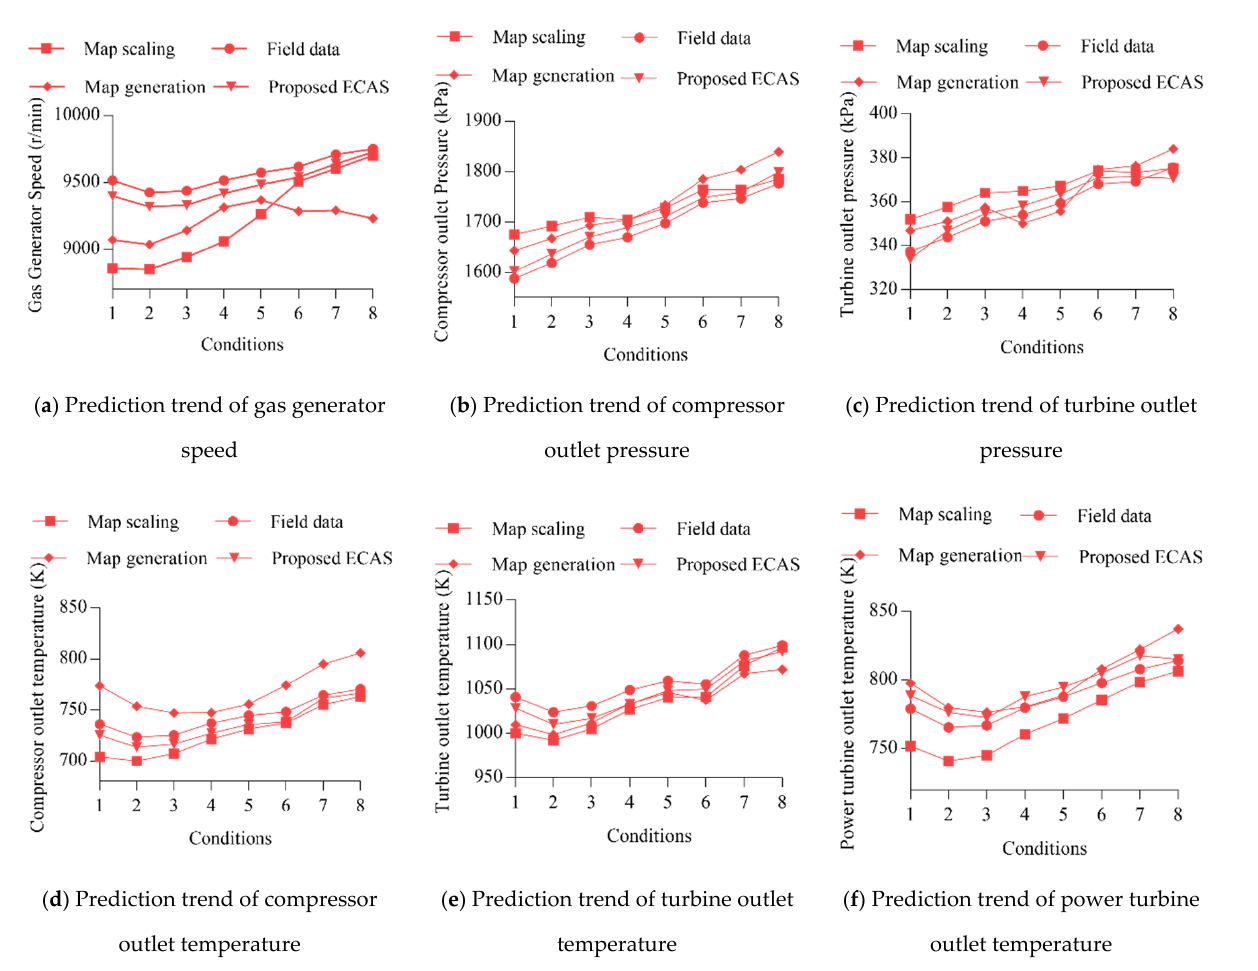
Figure 8. Prediction trends comparison with different adaptive methods.